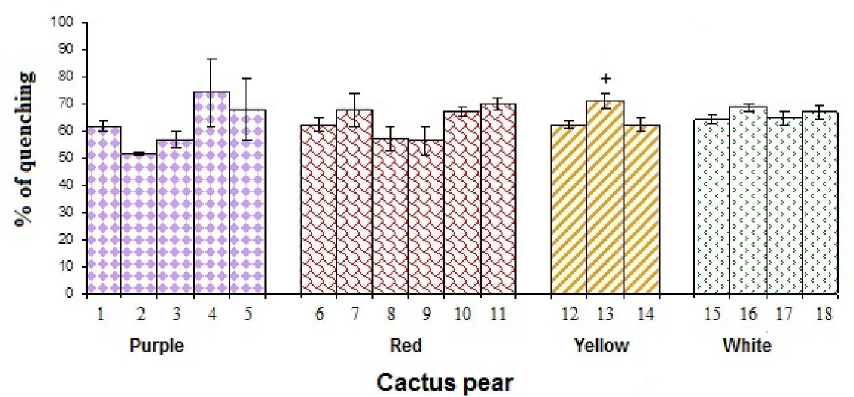
Figure 7. Chelating activity of cactus pear studied cultivars. * denotes statistical significance at p < 0.05 among all studied cultivars of cactus pears. + indicates statistical significance at p < 0.05 among the cultivars of cactus pears in the same